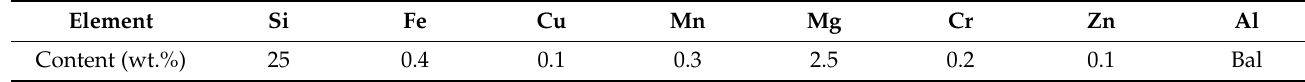
Table 1. Chemical Composition of 5052 Al Alloy.